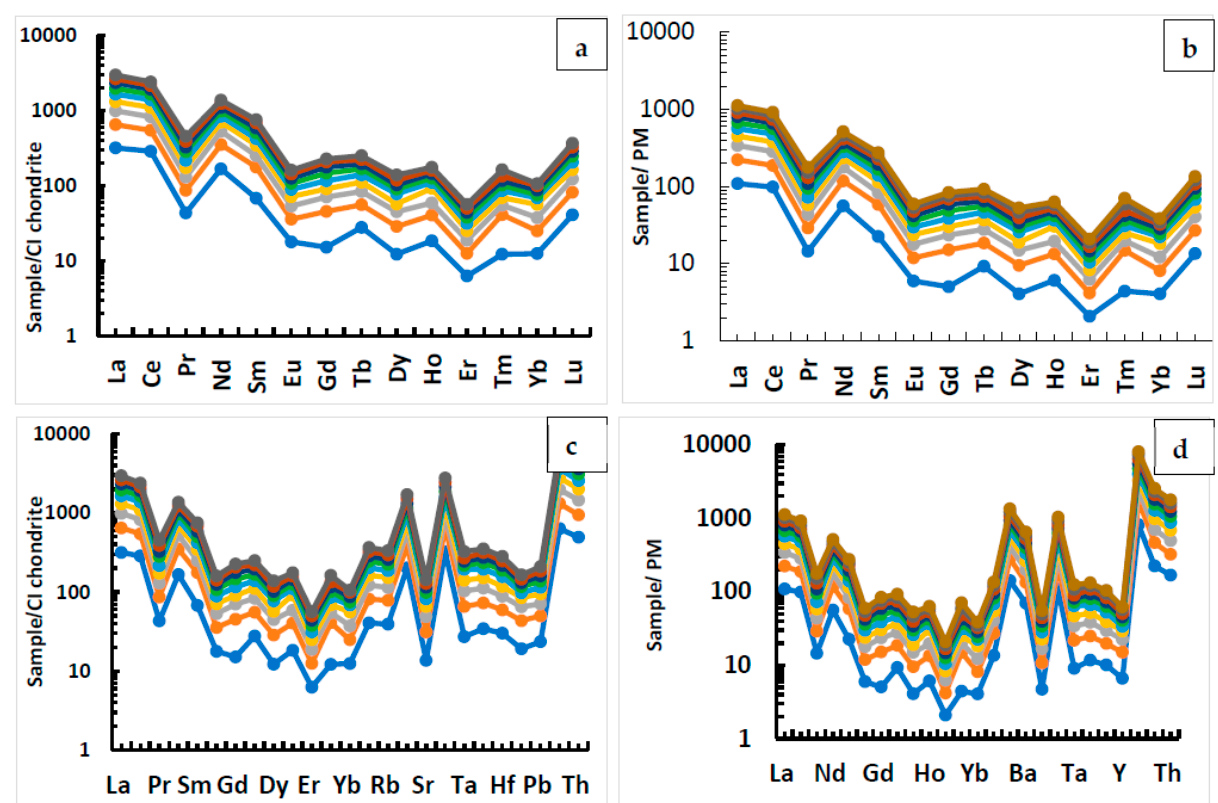
Figure 11. ( a ) REE ‐ Chondrite normalized [64] ( b ) REE ‐ Primitive mantle [65] spider diagrams of plagio ‐ granite. ( c ) Chondrite normaslized of trace ‐ REE pattern compositions of Abu Dabbab plagio ‐ granites (after [64]). ( d ) Primitive mantle normalized of trace ‐ REE pattern compositions of Abu Dabbab plagio ‐ granites (after [65]).